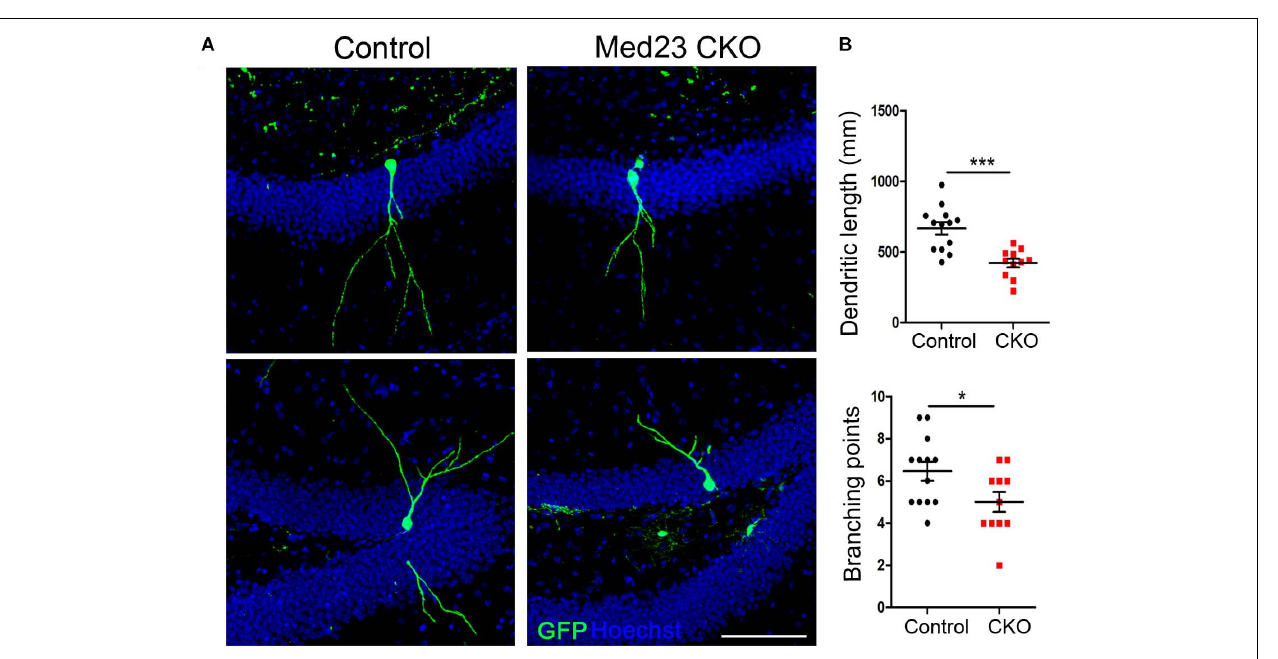
FIGURE 6 | Aberrant dendritic morphogenesis of newborn neurons in Med23 CKO mice. GFP-encoding retrovirus was injected into the dentate gyrus and analyzed 3 weeks later. (A) Representative confocal images showing dendrites of newborn neurons in the SGZ of Med23 CKO and control mice. Hoechst (blue) was used as counterstaining. Scale bar = 100 µ m. (B) Quantification of the total dendritic length and total branching points of GFP + newborn neurons. A total of 13 neurons from 3 control and 11 neurons from 3 Med23CKO mice were included. Data are plotted as the mean ± SEM. Student t -test, * p < 0.05, *** p <